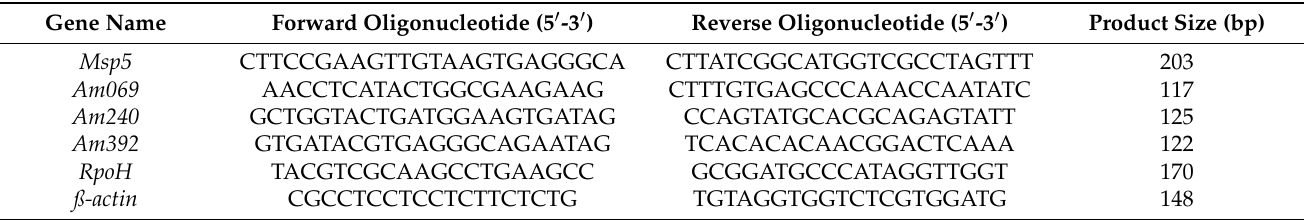
Table 2. Oligonucleotides used for